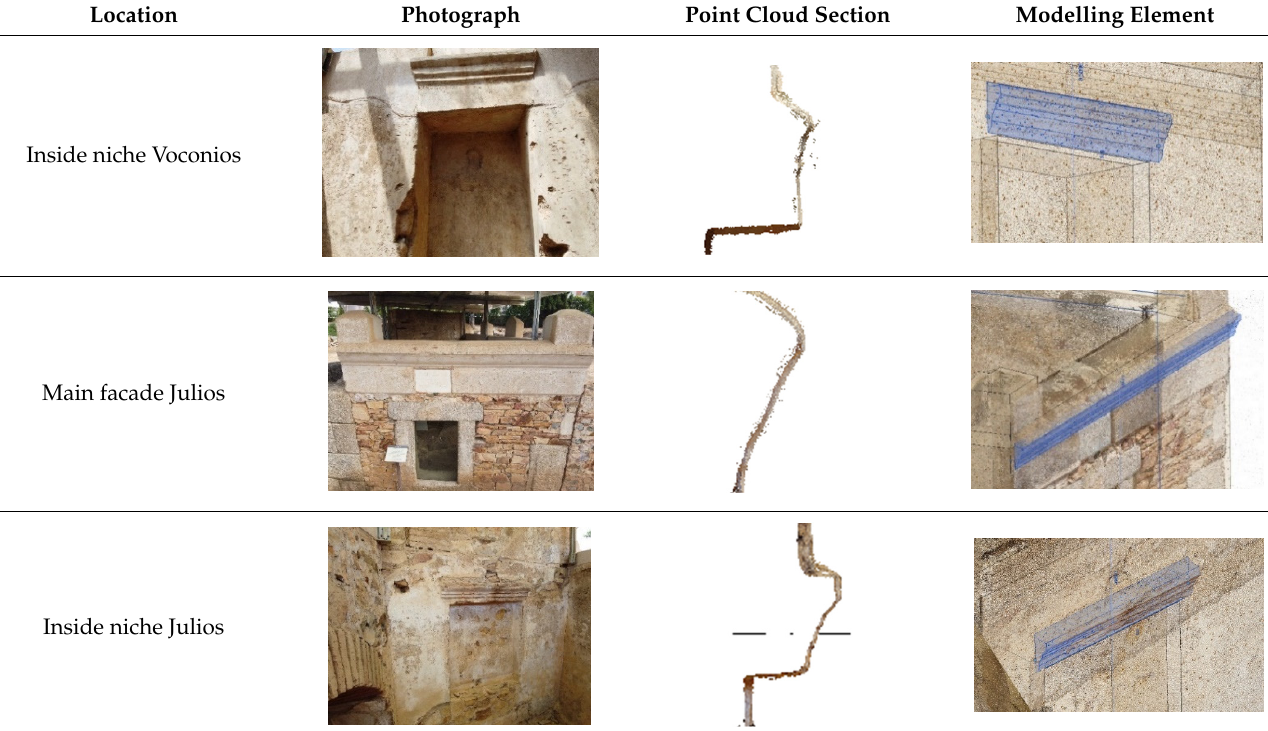
Table 7. Modelling of the decorative elements: Cornices.